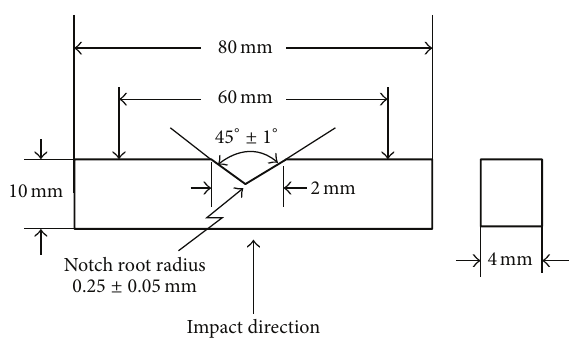
Figure 3: Geometry of the Charpy V-notch impact specimen used in this investigation